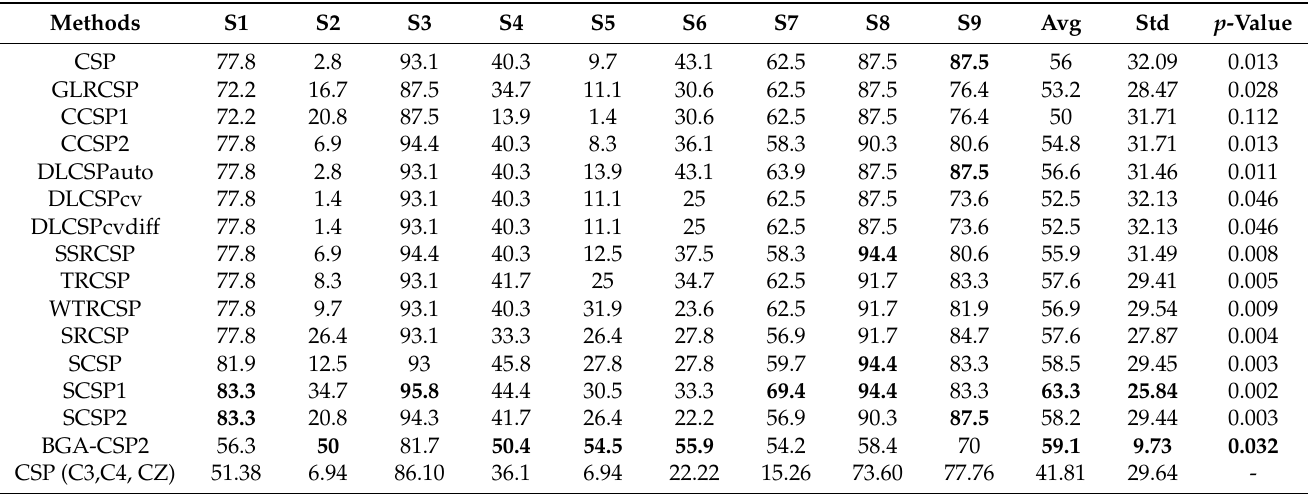
Figure 16. Examining the best kappa different methods for selecting features (along with feature extraction, reducing features and channels, etc.) on three channels with more than three channels by combining different selected bands and so on. Table 21. Checking the best kappa results of different methods compared with the proposed method